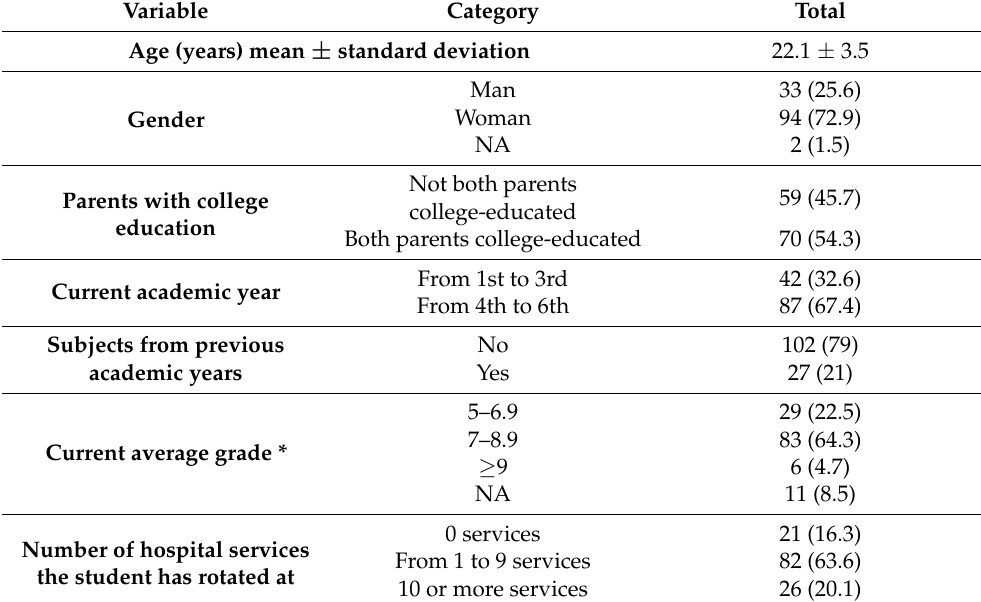
Table 1. Main characteristics of the students included in study.